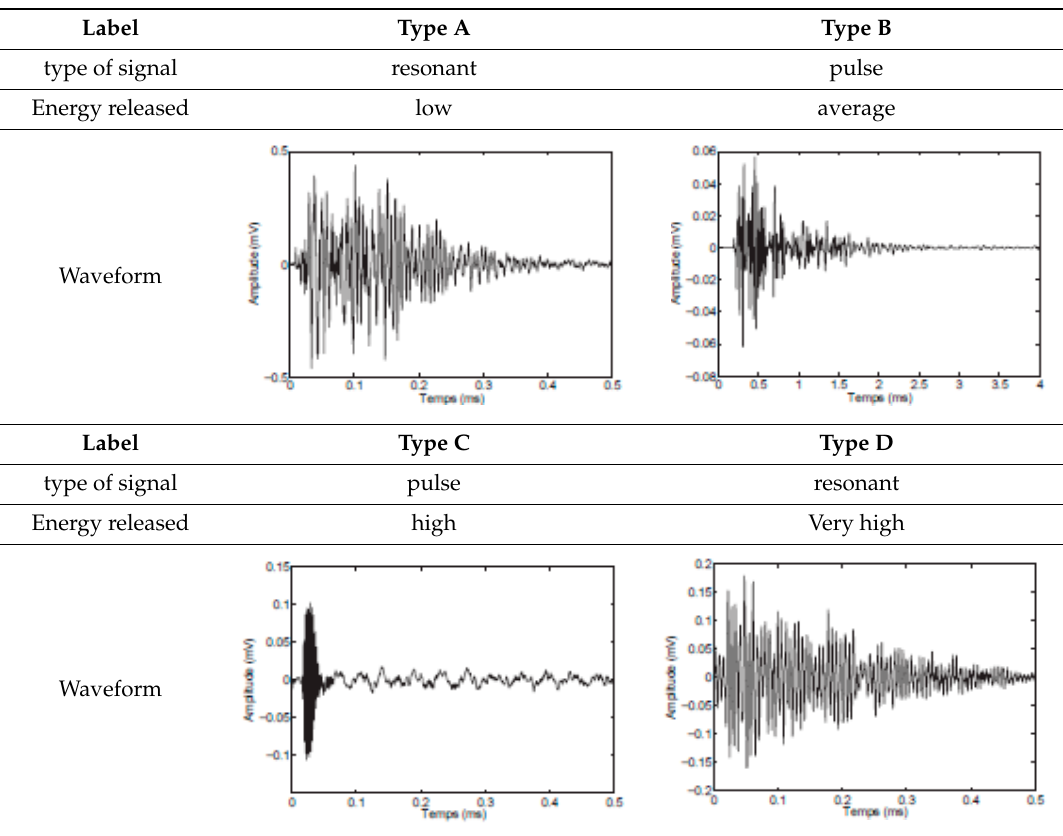
Table 7. Time characteristics of different waveforms.